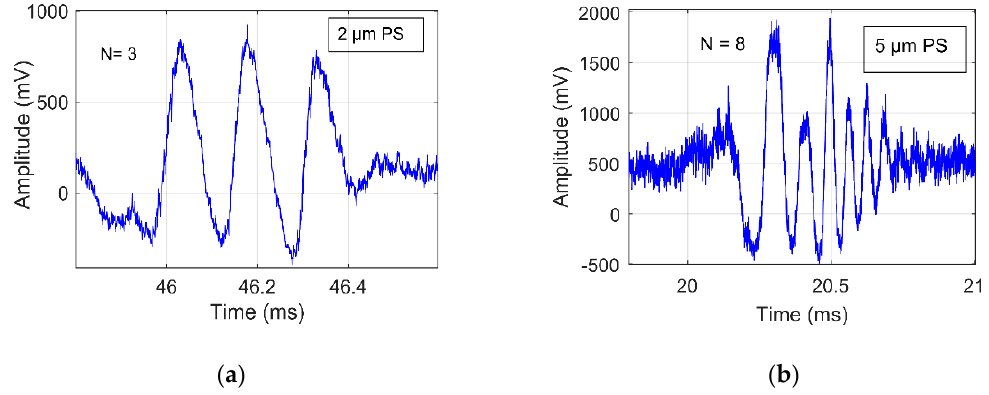
Figure 5. The SMI signal bursts polystyrene sphere (PS) particles in ( a ) 2 µ m diameter ( b ) 5 µ m